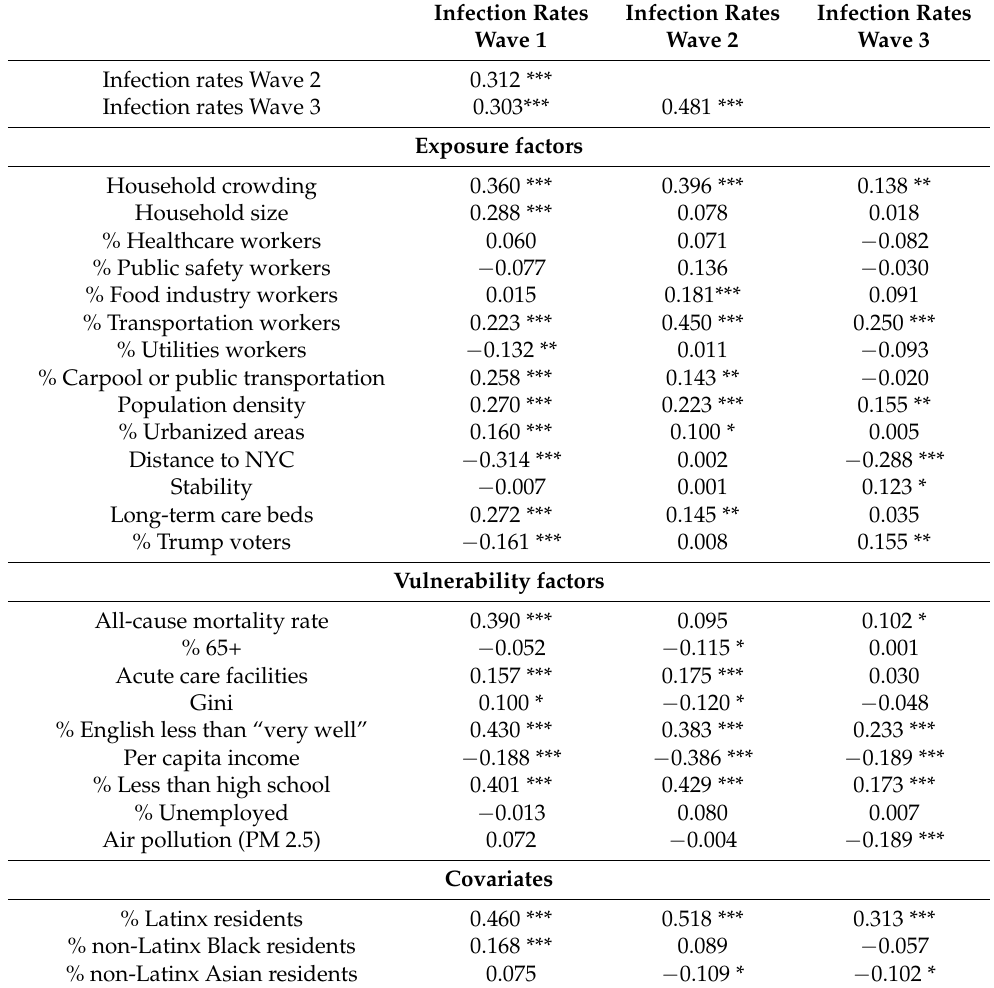
Table 1. Correlations of potential exposure/vulnerability factors with infection